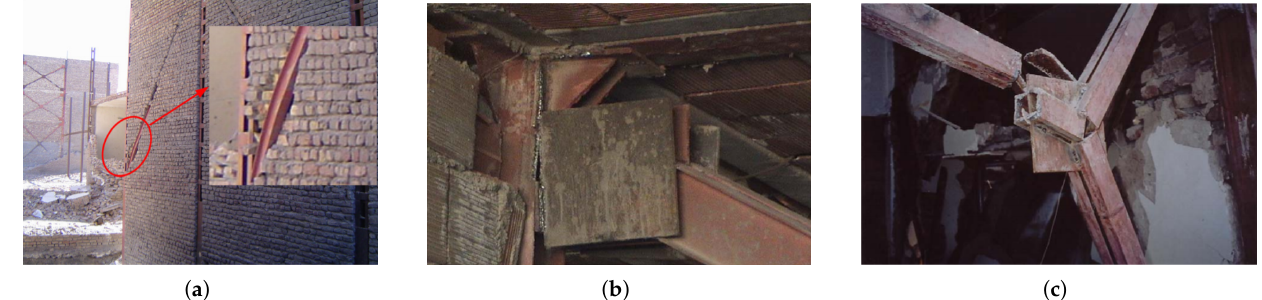
Figure 5. Failure of the lateral bracing system [32]; ( a ) out of plane buckling of bracing system; ( b ) fracture of connection in concentrically X-bracing system due to the poor welding quality; ( c ) bracing failure at splice